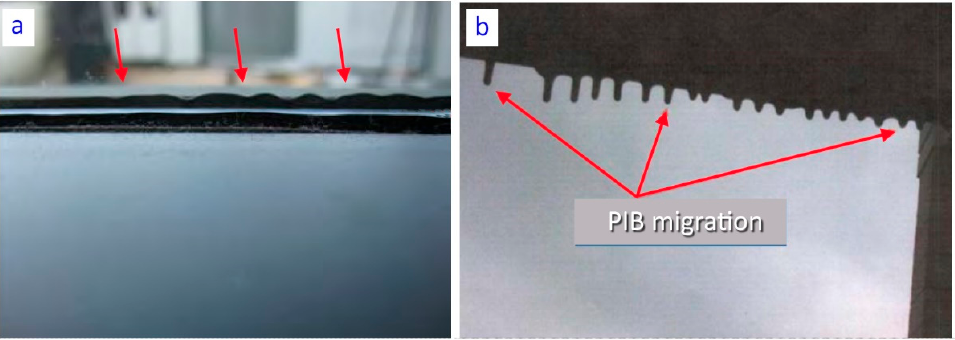
Figure 2. Examples of PIB failures: ( a ) squeeze out or “creep”, ( b ) migration [12].